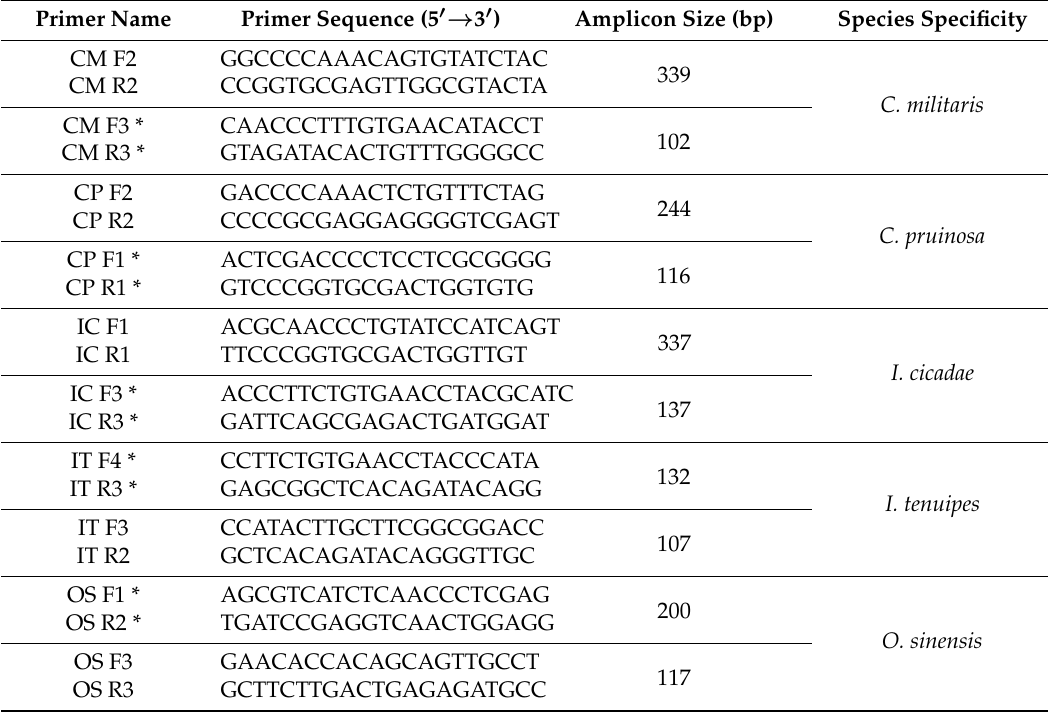
Table 3. Sequences of the sequence characterized amplified region (SCAR) primers, and the sizes and specificity of the amplified DNA